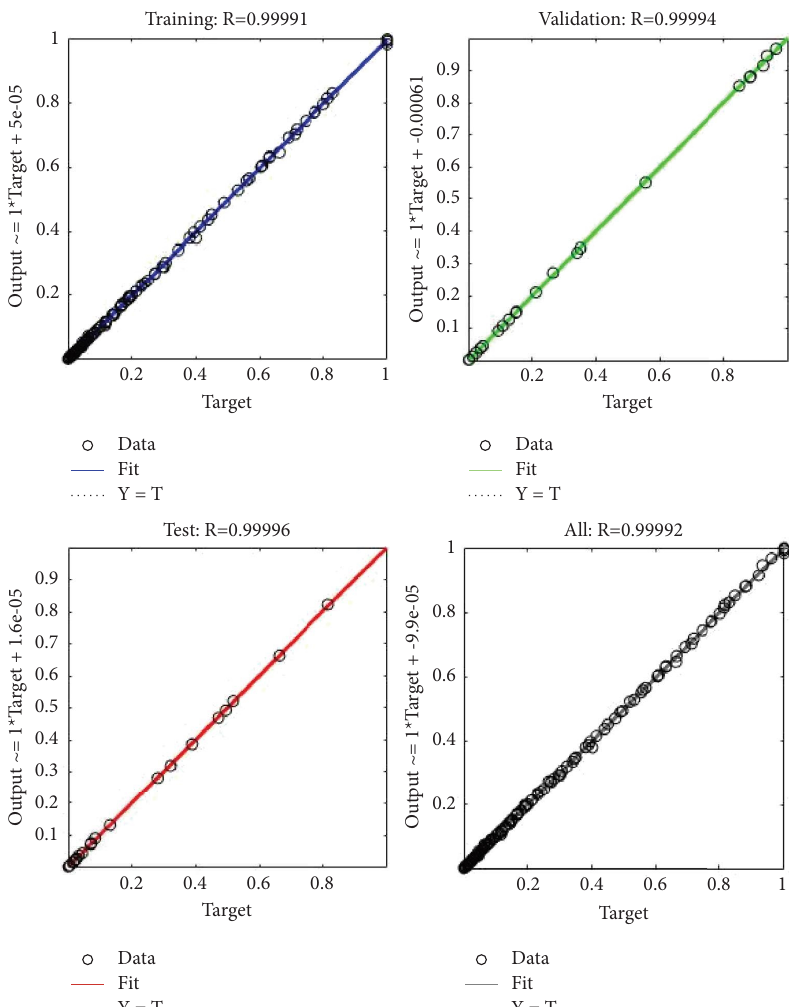
Figure 5: Comparison between experimental and predicted moisture ratios during training, validation, and testing of the best ANN model.